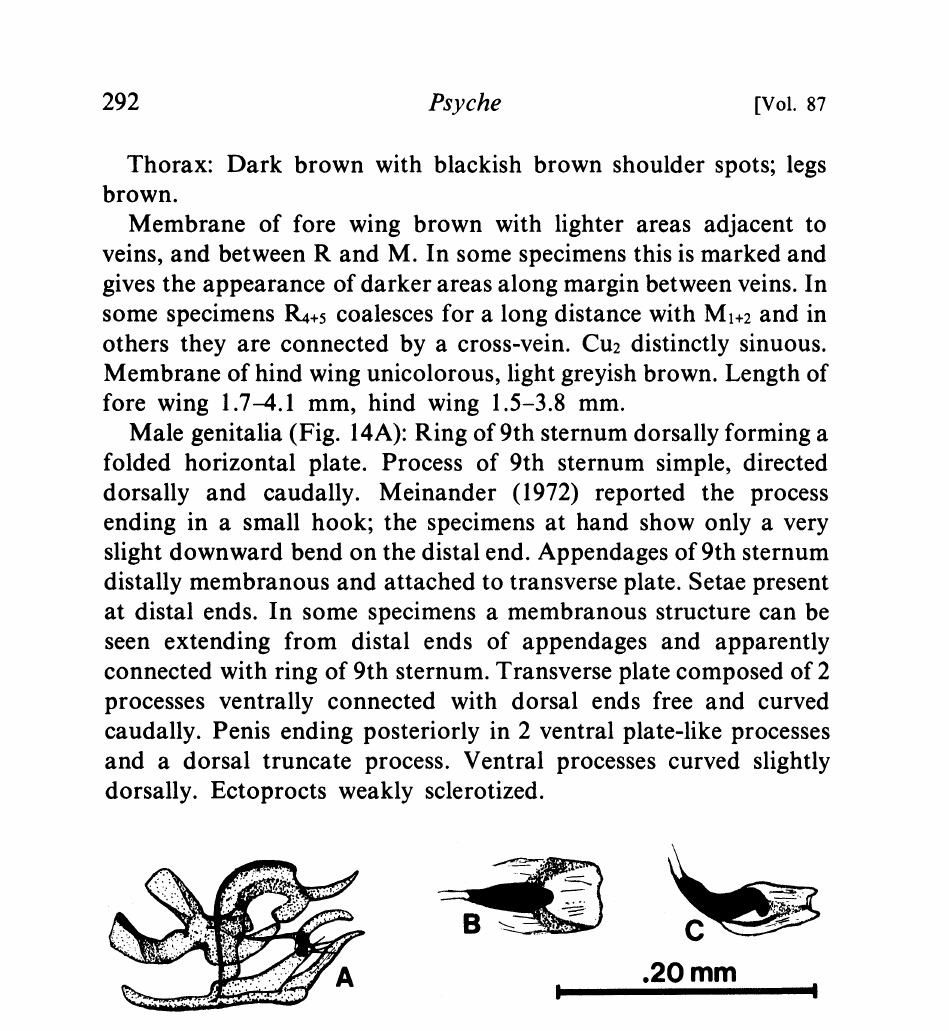
Figure 14. Aleuropteryx vulgaris. A. Male genitalia, lateral view. B. Female genitalia, ventral view. C. Female genitalia, lateral